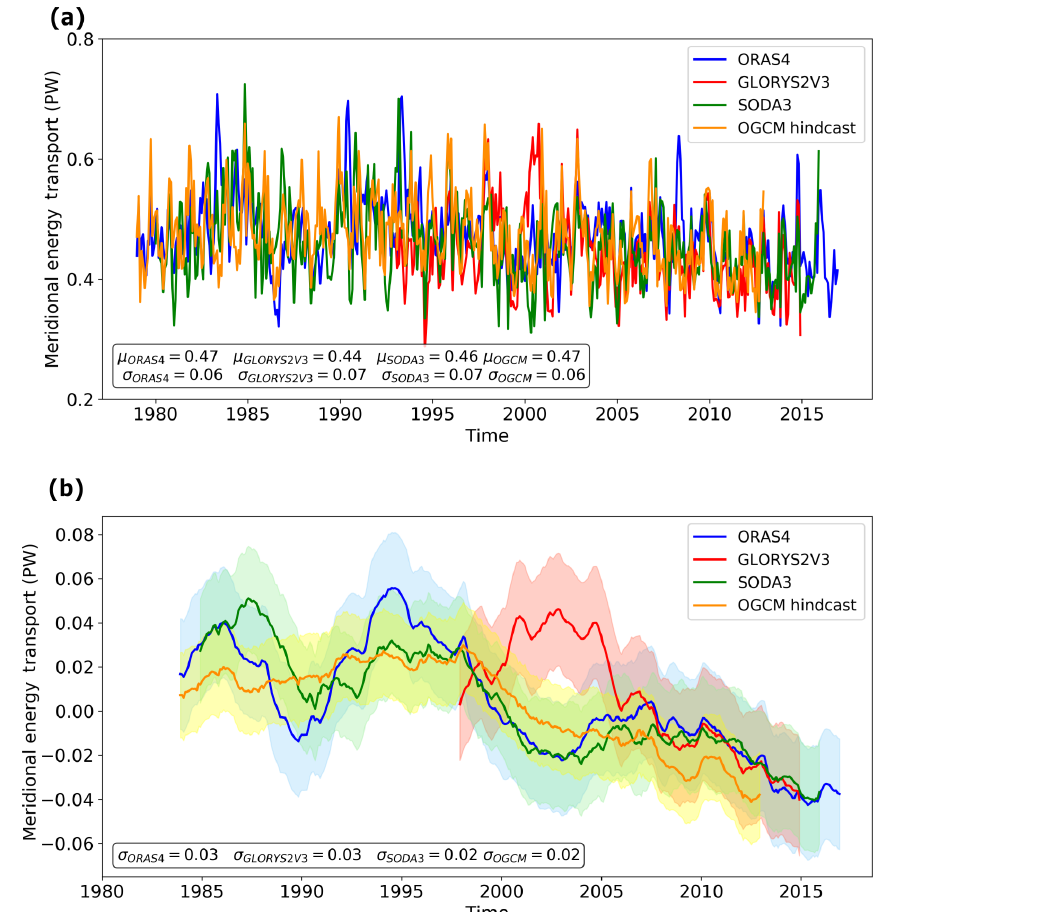
Figure 4. Time series of zonal integral of OMET at 60 ◦ N without/with a low-pass filter. (a) The original time series and (b) the ones with a low-pass filter include signals from ORAS4 (blue), GLORYS2v3 (red), SODA3 (green) and the OGCM hindcast (yellow). For the low-pass- filtered ones, we take a running mean of 5 years. The shades represent the confidence intervals with 1 standard deviation. σ is the standard deviation and µ is the mean of the entire time